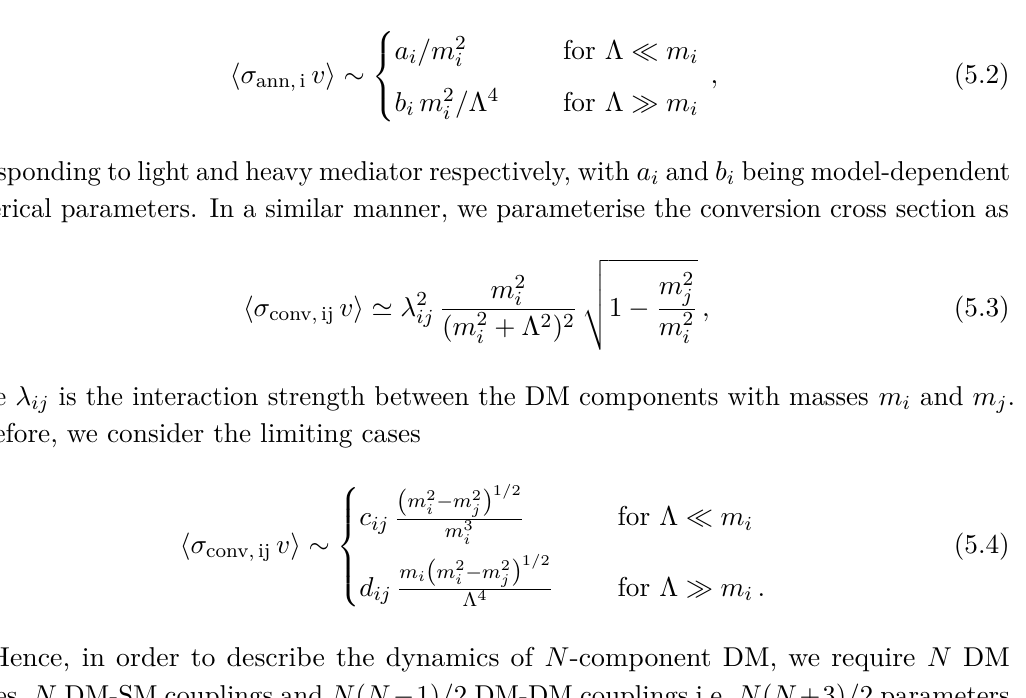
for large mass i